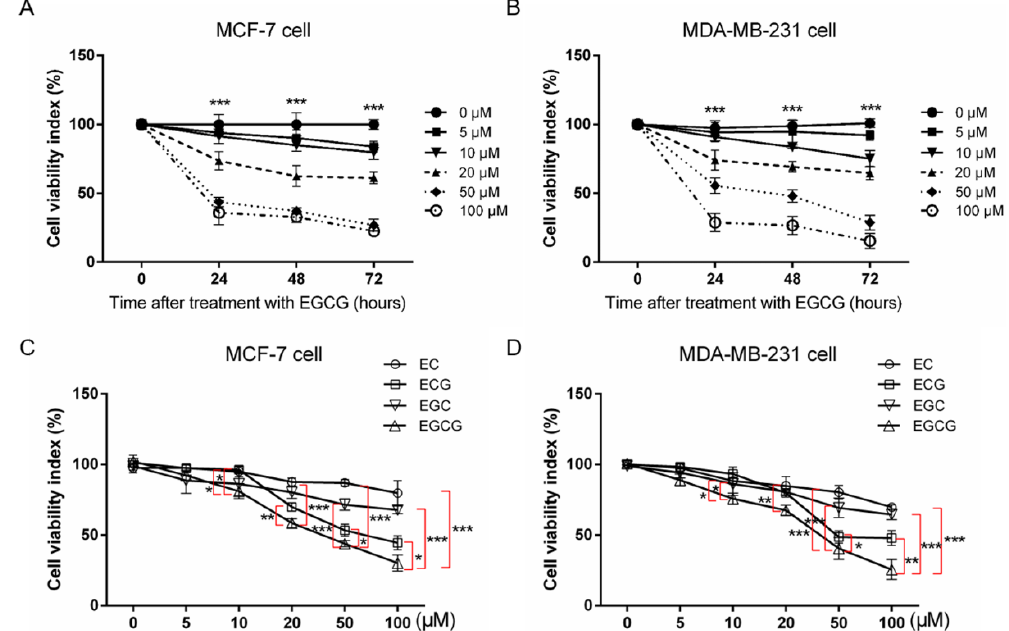
Figure 1. ( − )-Epigallocatechin-3-gallate (EGCG) inhibits cell viability of breast cancer cells. ( A ) Cell viability of the MCF-7 cell line treated with various EGCG doses for 24, 48, and 72 h. ( B ) Cell viability of the MDA-MB-231 cell line treated with various EGCG doses for 24, 48, and 72 h. We compared the cell viabilities of MCF-7 or MDA-MB-231 cells treated with various EGCG concentrations at 24, 48, and 72 h (one-way ANOVA; *** p < 0.001). ( C ) Cell viability of MCF-7 treated with various concentrations of EC, epicatechin; ECG, epicatechin gallate; EGC, epigallocatechin; and EGCG for 24 h. ( D ) Cell viability of MDA-MB-231 treated with various concentrations of EC, ECG, EGC, and EGCG for 24 h. We compared the cell viabilities of MCF-7 or MDA-MB-231 cells treated with EC, ECG, EGC, and EGCG (one-way ANOVA followed by Dunn’s multiple comparison post hoc test; * p < 0.05, ** p < 0.01, and *** p < 0.001 the EC, ECG, EGC group versus EGCG group, respectively). Data were presented as mean ± SEM from six independent experiments.